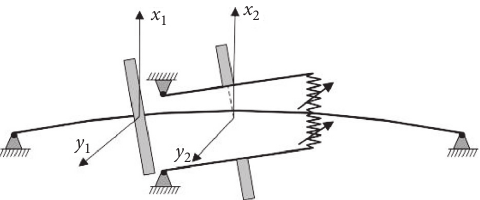
Figure 2: Lateral vibration of the dual-rotor